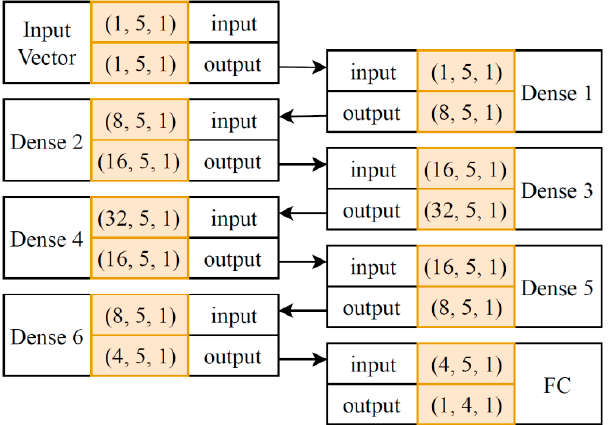
Figure 2. Proposed deep neural network (DNN) architecture for the aircraft trajectory regression problem (ATRP).